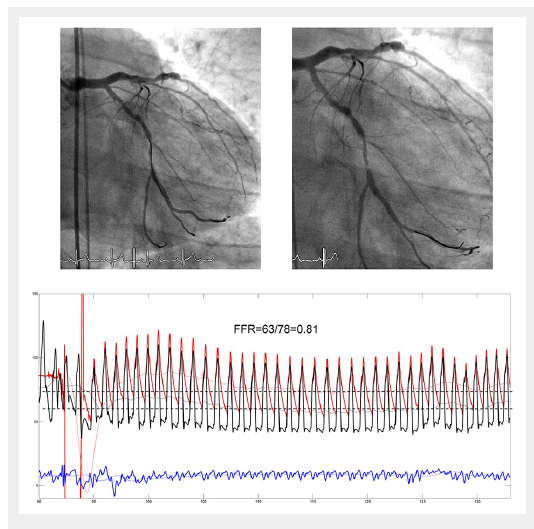
Angiogram of the left coronary artery with serial stenoses of the left circumflex artery (upper panels). The pressure sensor wire (location of the sensor at the end of the opaque tip) is first positioned proximal to the tightest stenosis (left upper panel), and then distal to it (right upper panel). The pressure tracings (lower panel) are recorded with the pressure sensor distal to the stenoses (wire tip in the marginal branch). The following phasic and mean pressures are recorded simultaneously: Aortic pressure, P ao (mean) in red, coronary pressure distal to the stenoses in black (P d ), central venous pressure in blue (CVP). Fractional flow reserve (FFR) is taken as the steady state minimum ratio of P d /P ao (broken lines) over several cardiac cycles.